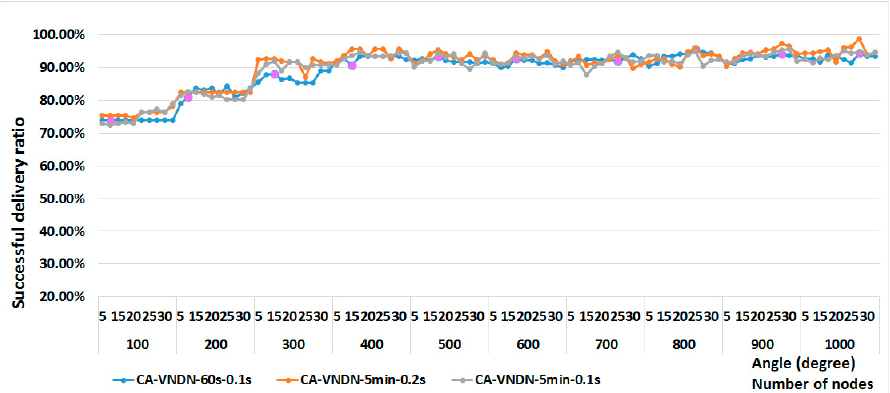
Figure 19. Successful delivery ratio under different simulation time and content sending interval.